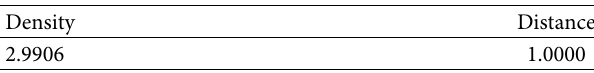
Table 3: Index of passing track network of Huskies in Match